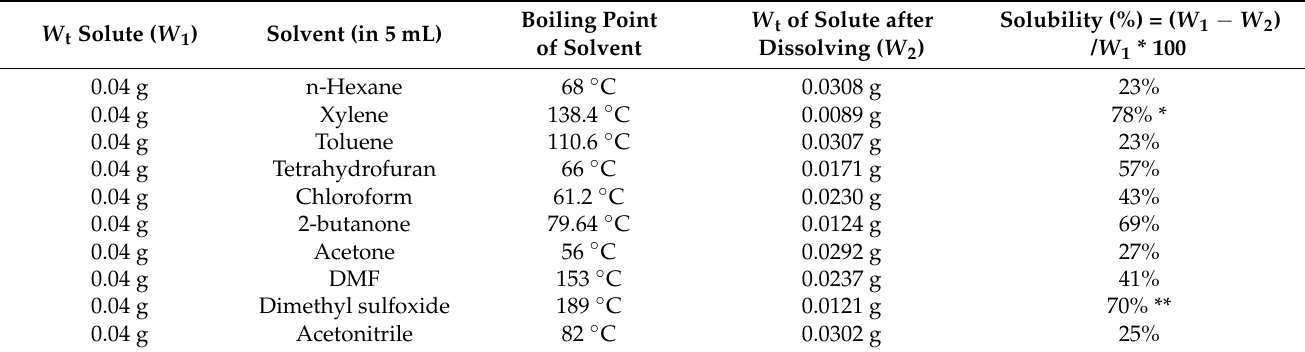
Table 2. Solubility (%) of the grafted products ACN- g -ENR in different organic